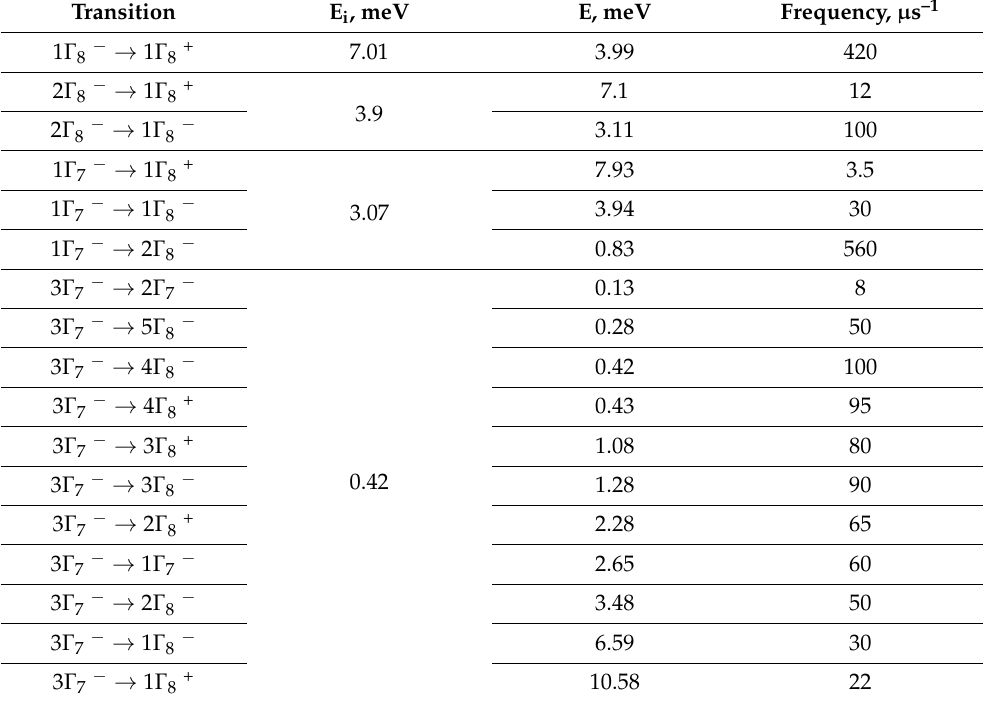
Figure 1. THz PL spectrum of a bulk n -type Hg 0.78 Cd 0.22 Te epitaxial layer upon excitation with an intensity of 10 mW/cm 2 and the PC spectrum of the p -type Hg 0.78 Cd 0.22 Te layer. The temperatures at which measurements were taken are indicated in the figure. The arrows indicate the features of the PL spectrum. The gray area indicates the long-wavelength limit of the beamsplitter exploited in the PL study. Table 2. Calculated energies (E) and frequencies of transitions between the lower states of a neutral mercury vacancy upon emission of an acoustic phonon in the Hg 0.78 Cd 0.22 Te ternary alloy. The ionization energies (E i ) of the initial states of the transitions are also